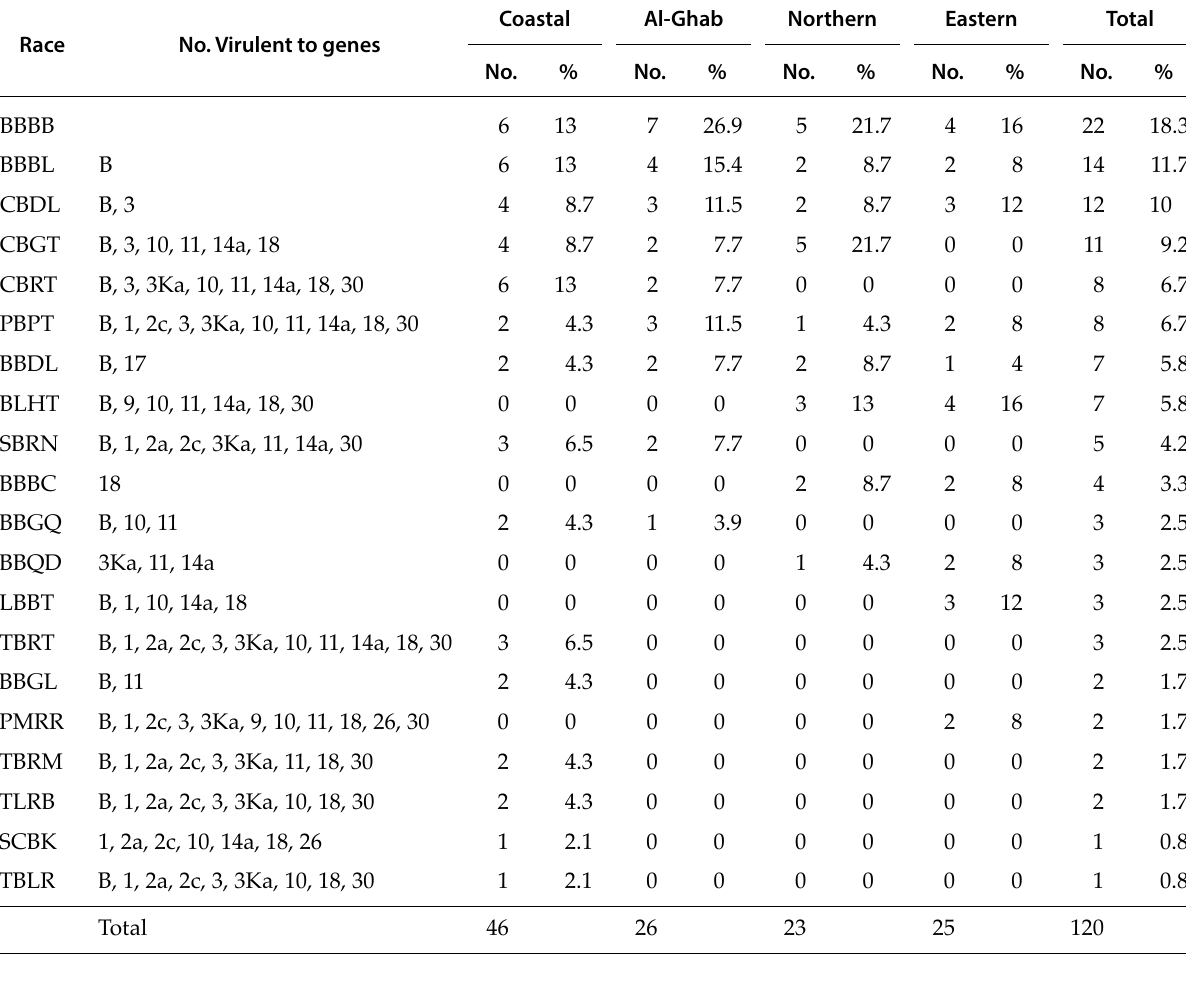
Table 1. Number and frequency (%) of virulence phenotypes of Puccinia triticina in four Syrian regions in 2010